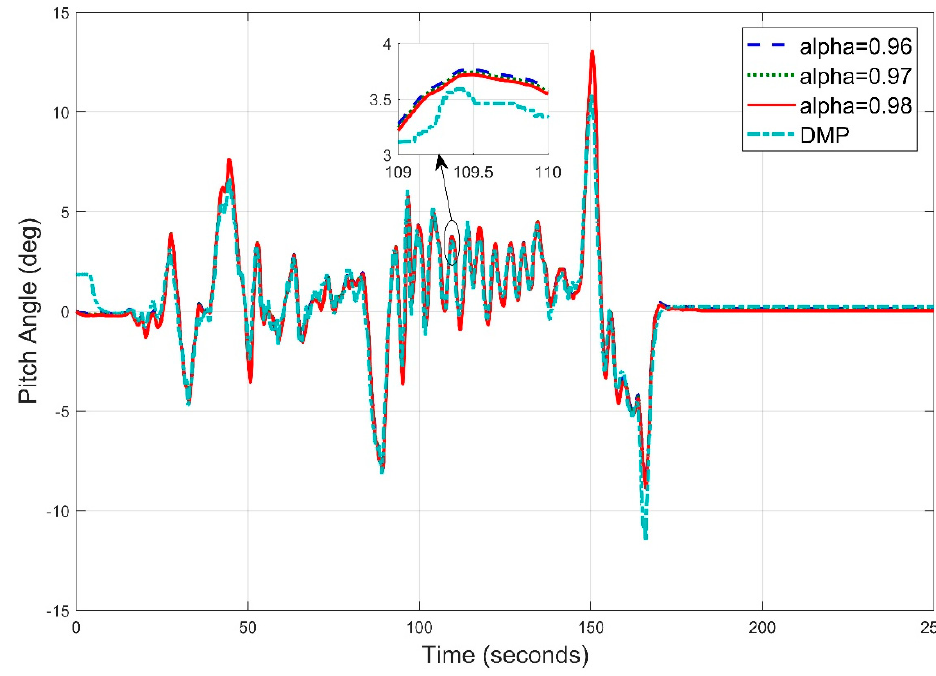
Figure 28. Real Time Pitch Angle Estimate at f = 40 Hz for Complementary Filter.